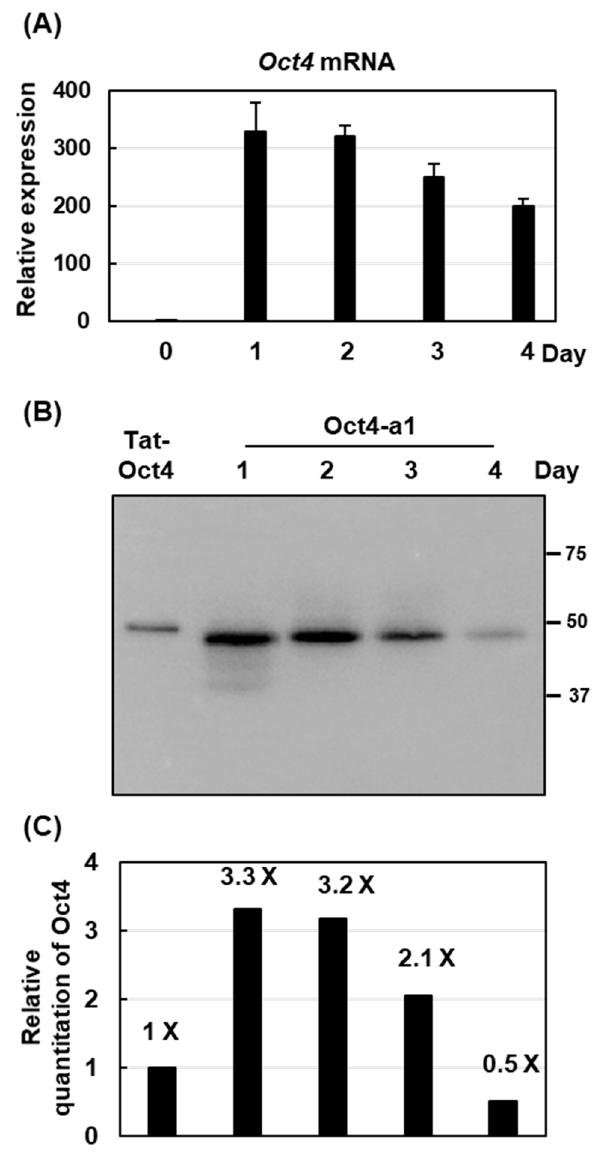
Figure 4. The production profile of rhOct4 in rice suspension cells. Three milliliters of Oct4-a1 suspension cells were cultured in 25 mL sugar-free MS for 1 to 4 days. Total RNA and total soluble proteins were isolated and subjected to qRT-PCR and western blot analysis. ( A ) Relative expression of Oct4 was determined with Oct4 -specific primers. Error bars indicate the standard deviation (SD) of triplicate experiments. Gene expression was relative to that at Day 0, with 1 = equivalence. ( B ) Western blot analysis was performed using Oct4 antibodies. Equal quantities of total protein (40 µg) per lane were loaded. Fifty grams of commercial TAT-Oct4 recombinant protein produced from E. coli was used as a positive control. ( C ) Relative quantification of rhOct4 protein yield in Oct4-a1 under various sugar-starvation durations was measured using a Bio-Rad Gel Doc EZ Imager system. The level of rhOct4 was relative to that of Tat-Oct4, with 1 = equivalence.